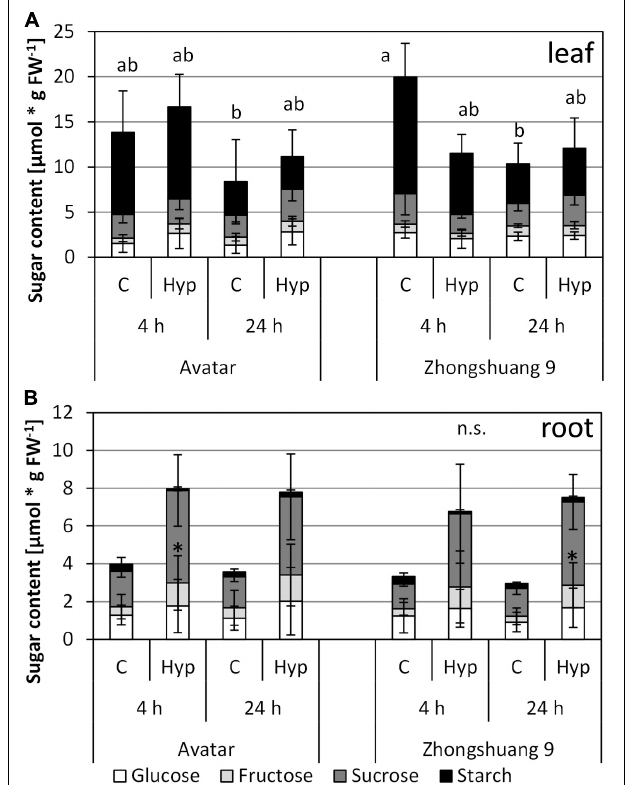
FIGURE 4 | Content of carbohydrates [ µ mol ∗ g FW − 1 ] in leaves (A) and roots (B) of two Brassica napus cultivars (Avatar, Zhongshuang 9) in hydroponics after 4 and 24 h of root hypoxia, compared with aerated controls. At time of start of stress, plants were 15 days old. Data are means ± SD of 5 replicates. Different letters indicate significant differences for the sum of sugars (ANOVA and Tukey post hoc test, p < 0.05). n.s., ANOVA was not significant; ∗ , significant compared with respective control ( T -Test, p <